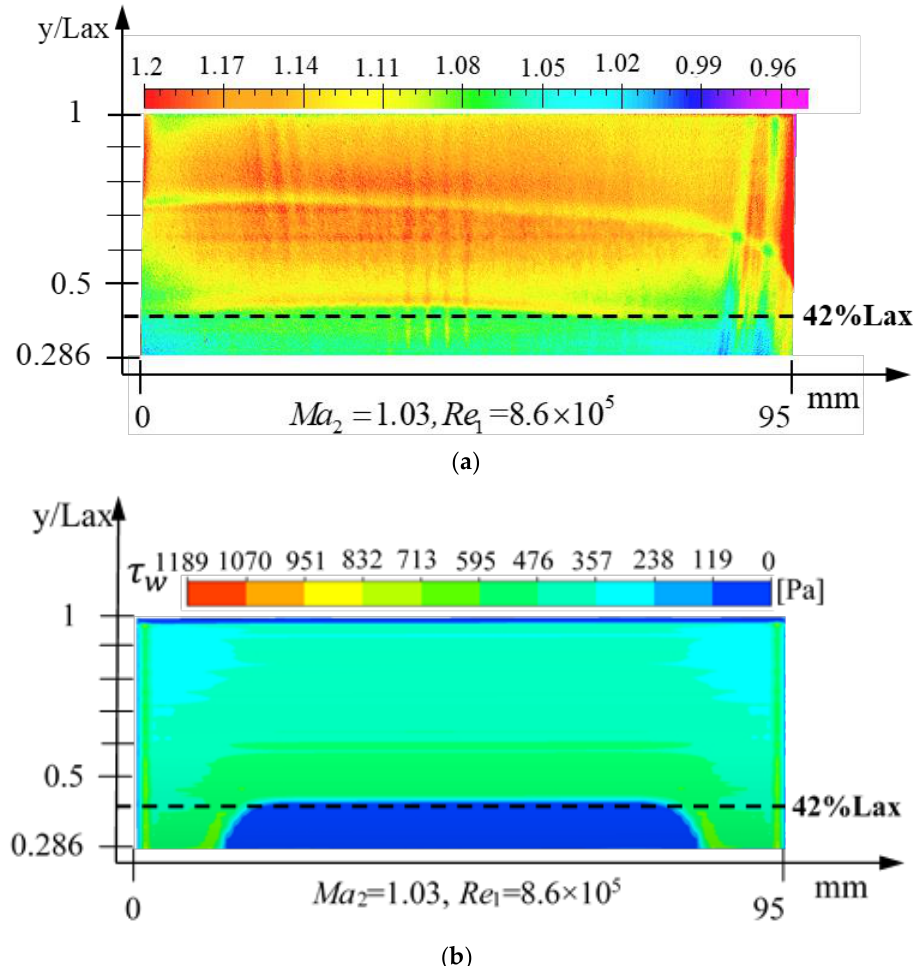
Figure 9. Comparison of transitions on the blade surface. ( a ) Experiment; ( b ) numerical simulation.